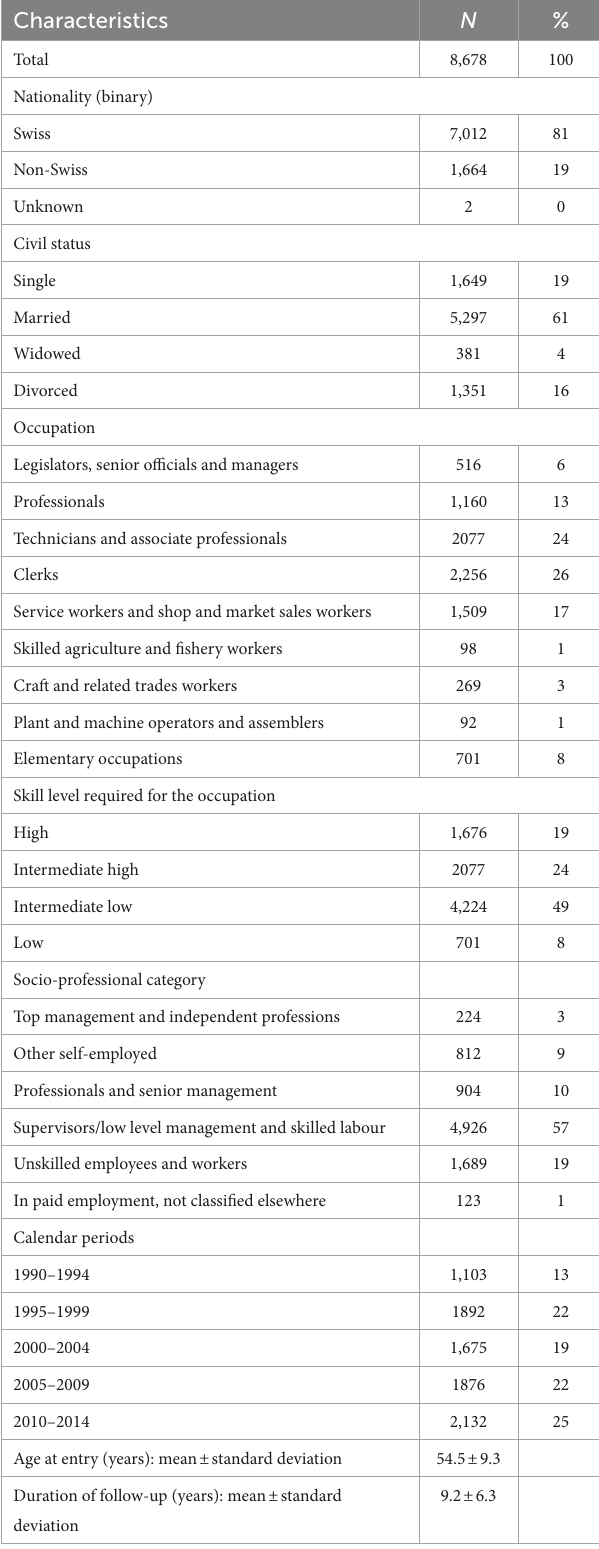
TABLE 1 Description of the study